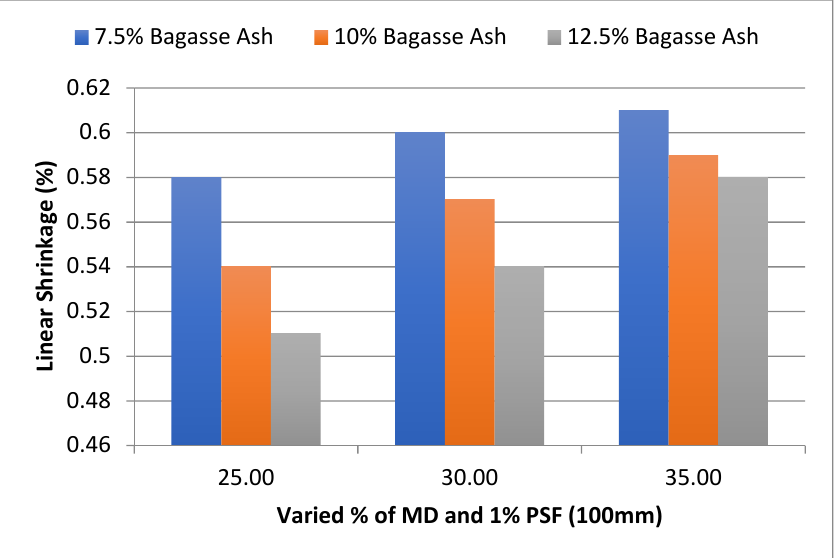
Figure 15. Effect of MD and BA on linear shrinkage of block reinforced with 1% PS fiber (100 mm).